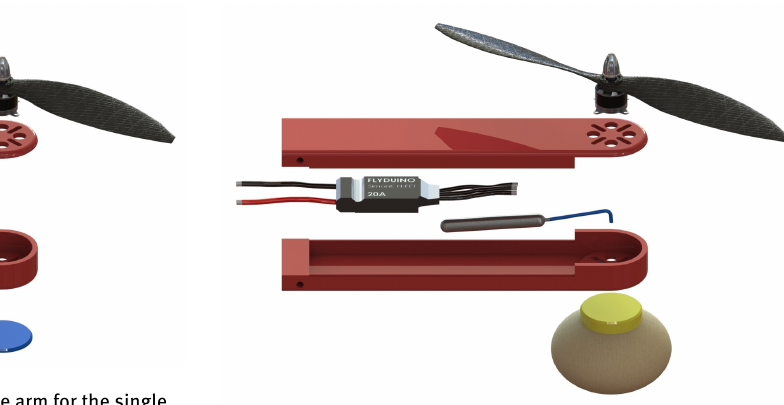
Figure 8: Electronic and avionic elements in the arm for the single rotor configurations.